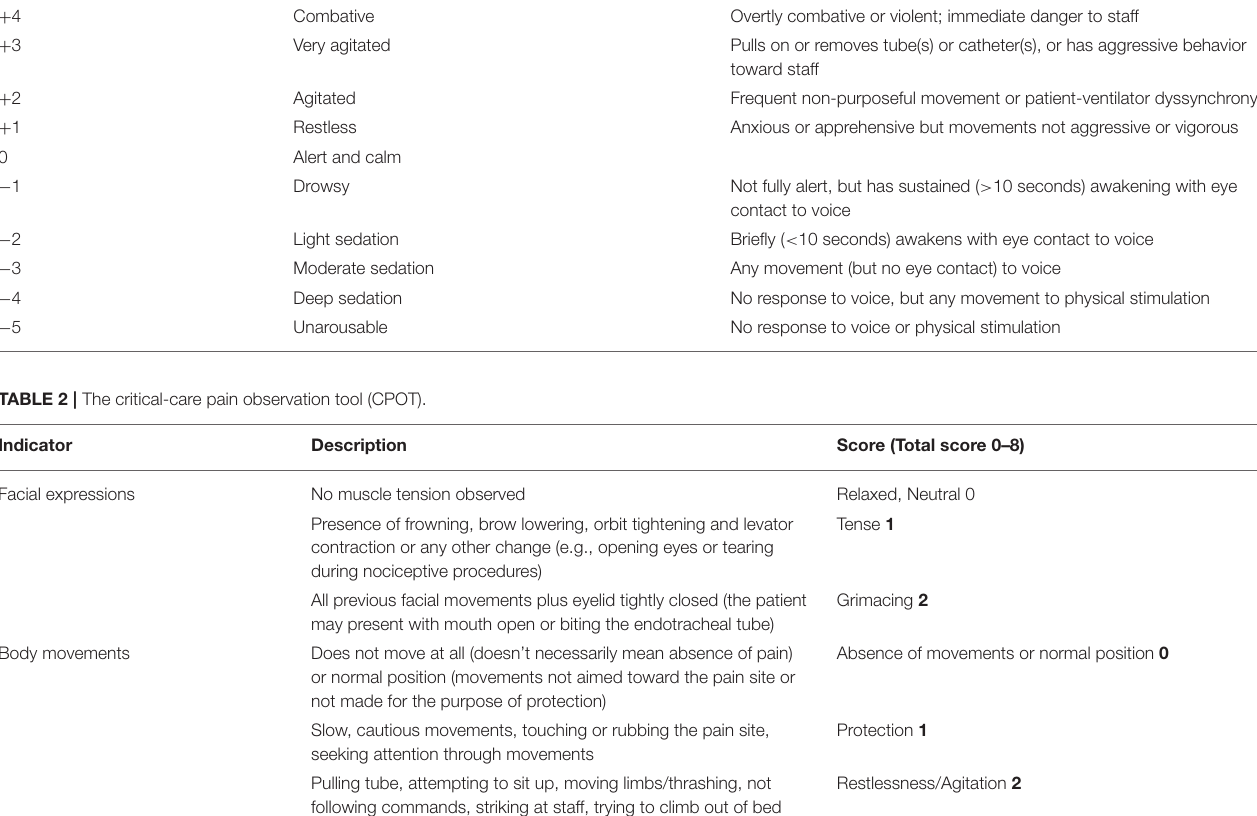
TABLE 1 | Richmond agitation-sedation scale (RASS).